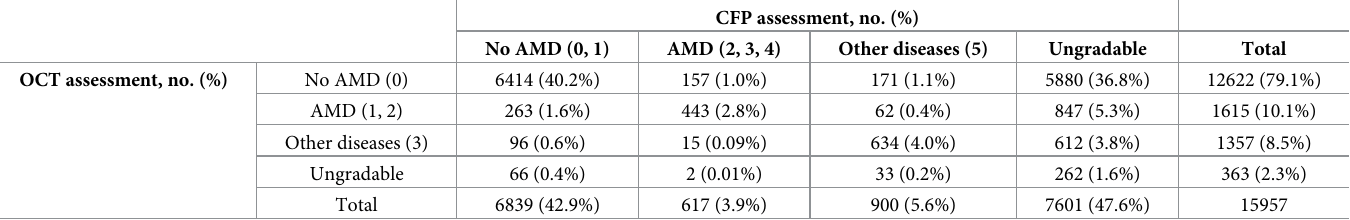
Table 1. Comparison between color fundus photography and optical coherence